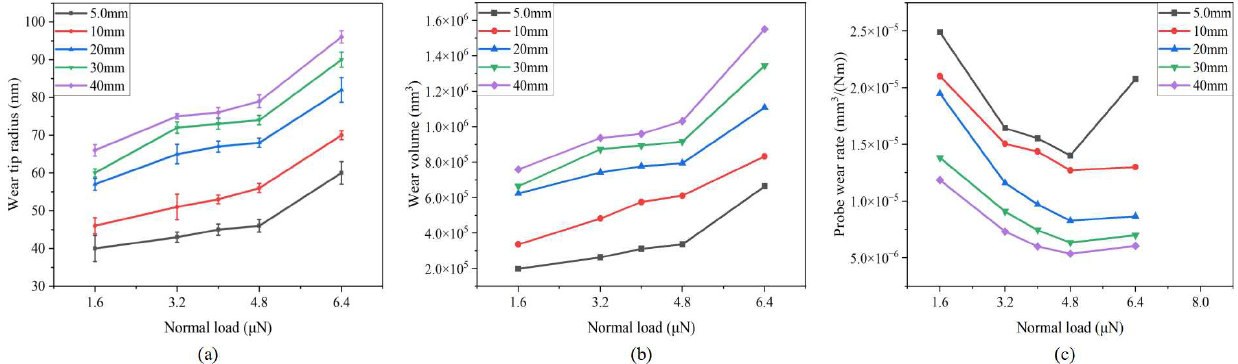
Figure 9. Relationship between normal load and evaluation index of probe wear state: ( a ) wear tip radius; ( b ) wear volume; ( c ) probe wear rate .